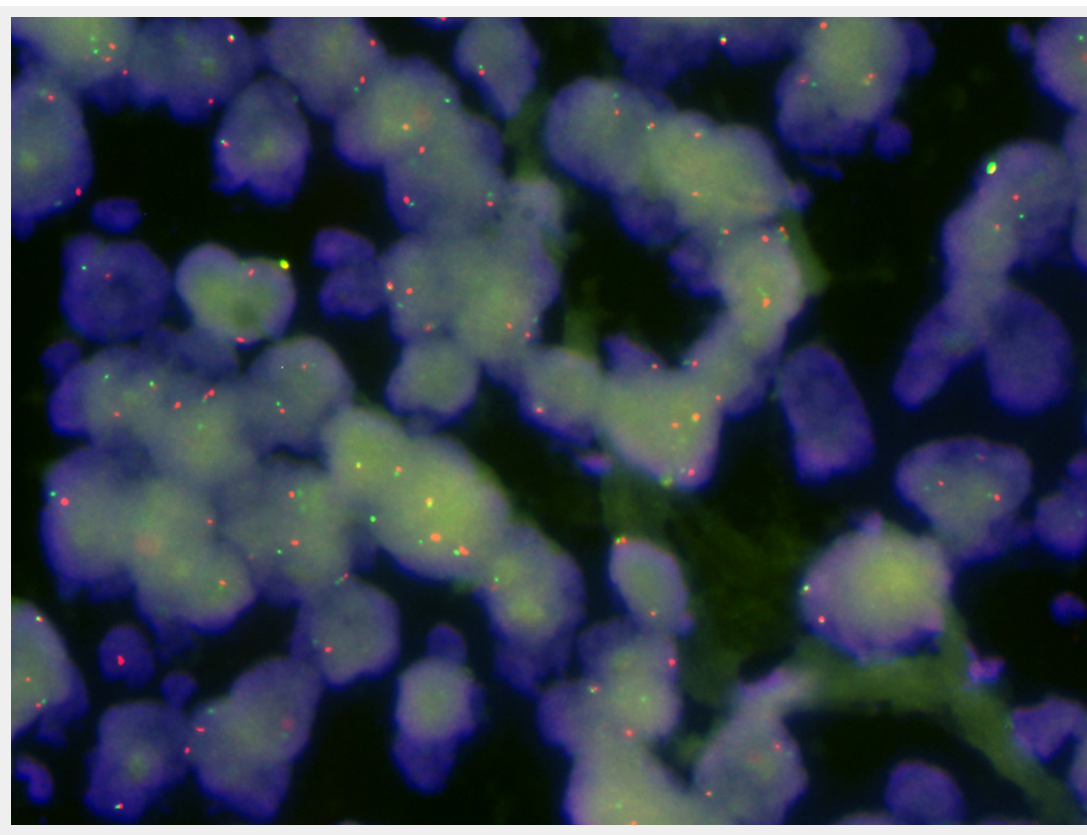
Figure 2 C-MYC gene rearrangement, demonstrated by a “break-apart” FISH probe. Note free green and red signals corresponding to the rearranged allele as well as fused signals corresponding to the second non-rearranged